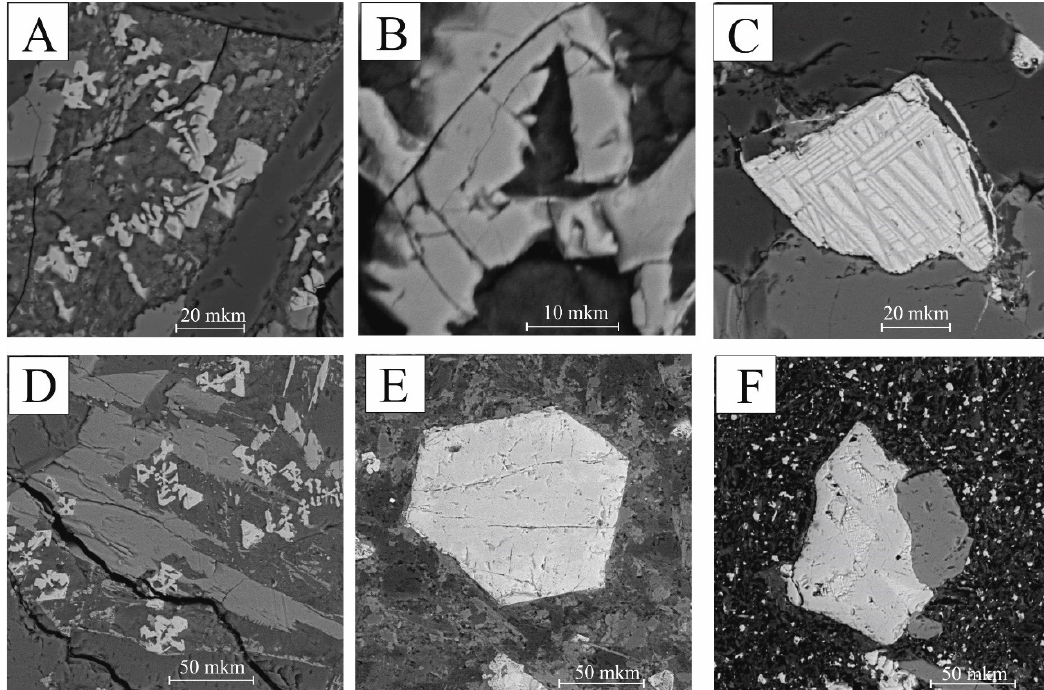
Figure 4. Representative SEM images of the studied samples. ( A ) Dendrites of titanomagnetite. Sample 140, site on34 , Onkuchaksky Formation. ( B ) Titanomagnetite with fracturing typical for low-temperature maghemitization. Sample 164, site on39 , Onkuchaksky Formation. ( C ) Titanomagnetite with structures of deuteric oxidation. Sample 349, site tv21 , Tyvankitsky Formation. ( D ) Large dendrites of titanomagnetite. Sample 524, site s5 , Tyvankitsky Formation. ( E ) Large titanomagnetite grain with structures of low-temperature oxidation. Sample 228, location 5, Lower Delkansky Formation. ( F ) Titanomagnetite grain with complex decay structures. Sample 743, location 9, Upper Delkansky Formation.